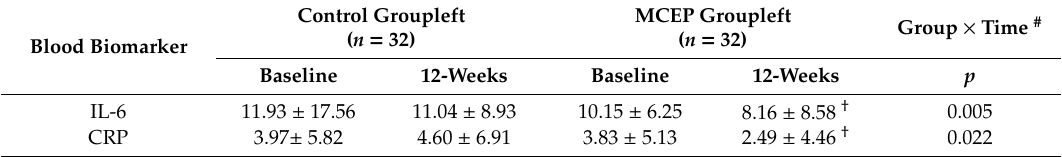
Table 4. Comparisons of outcome between groups in blood biomarker at baseline and 12